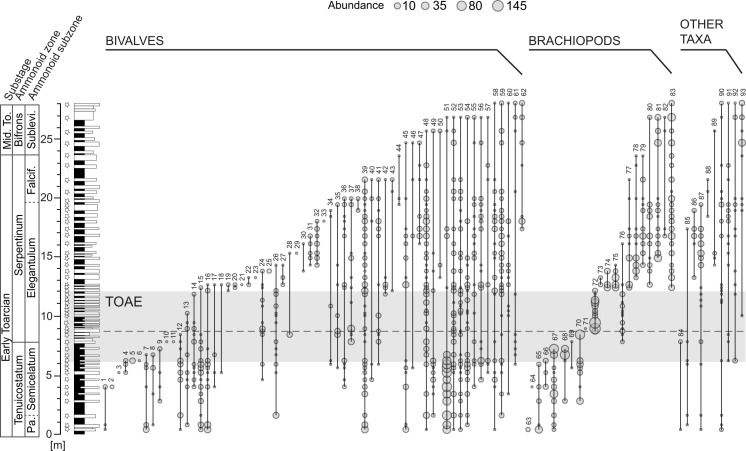
Stratigraphy and ranges of benthic macroinvertebrate species at Barranco de la Cañada.Taxa are ordered by last occurrences, and subdivided into taxonomical groups. Each circle represents the presence of a taxon at a sampled level, the size reflecting the abundance of the taxon. The star-shaped symbols indicate the sampled levels. The shaded grey area represents the extent of the chemostratigraphically defined Toarcian Oceanic Anoxic Event (TOAE) interval. Chronostratigraphic boundaries modified from ref. [14]. The horizontal dashed line marks the level with the last appearances of the pre-TOAE brachiopod fauna.